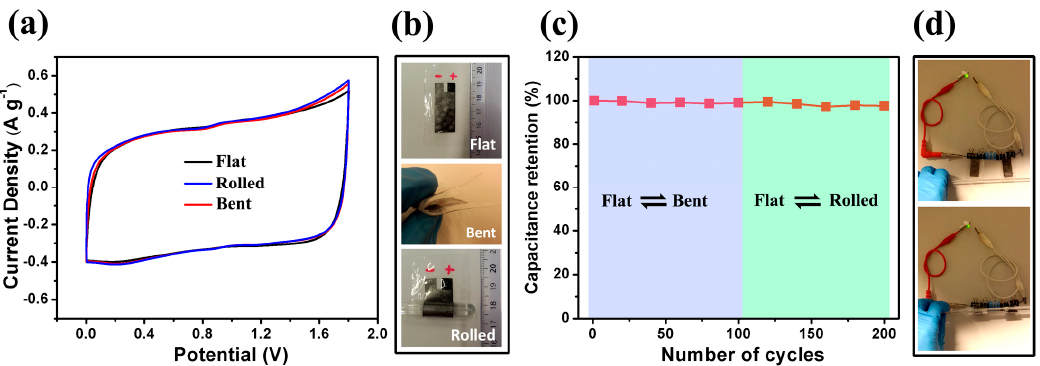
Figure 6. Flexibility of an asymmetric MnO 2 /RGO//RGO device. ( a ) CV curves at 10 mV s − 1 at three different bending states: ( b ) flat, bent, and rolled; ( c ) Capacitance retention after cycles of repeating flat/bent and flat/rolled; ( d ) Photograph displays a green light-emitting diode (LED) lighted by two asymmetric devices in a series, and demonstrates no obvious performance change of LED from the flat state to rolled state.